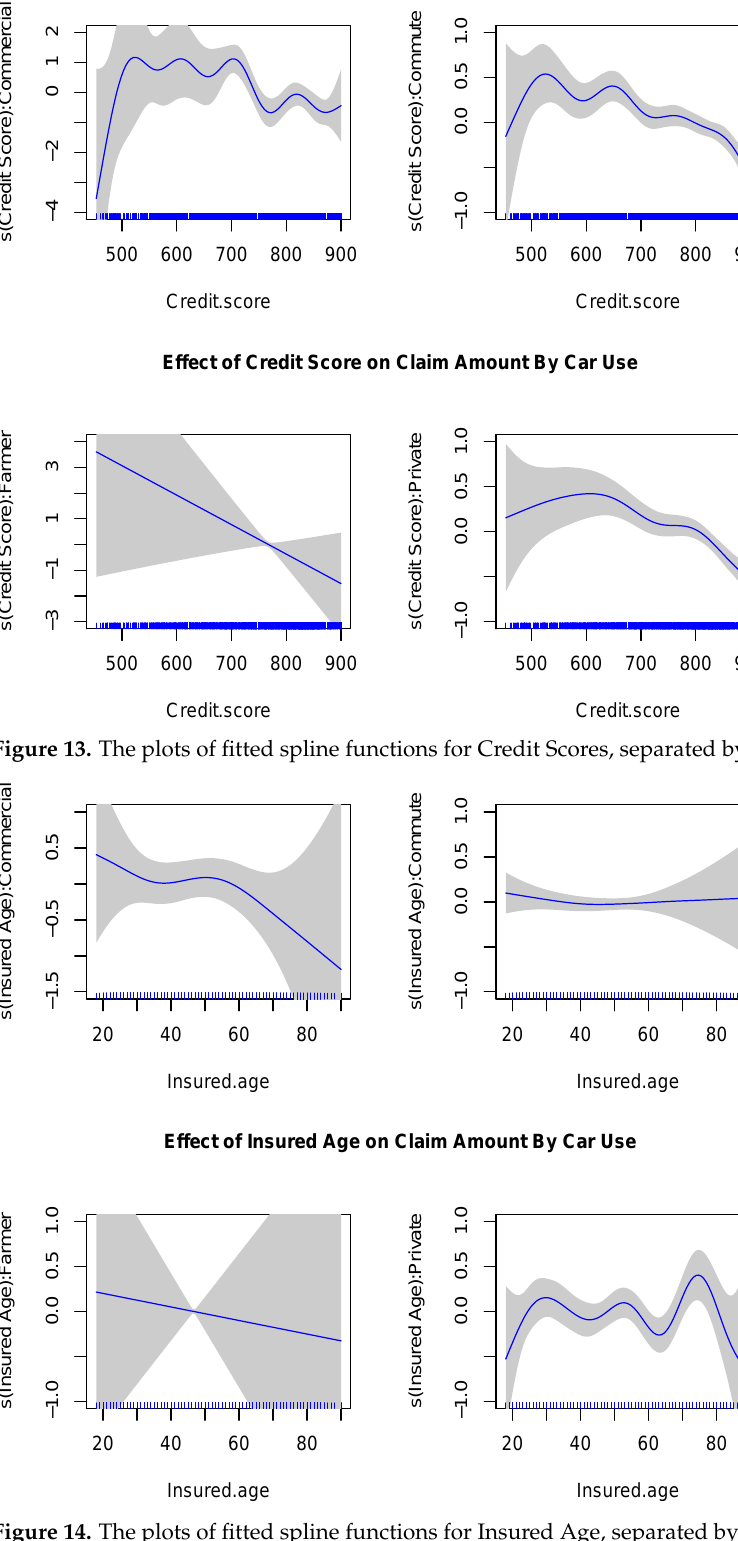
Figure 14. The plots of fitted spline functions for Insured Age, separated by Car